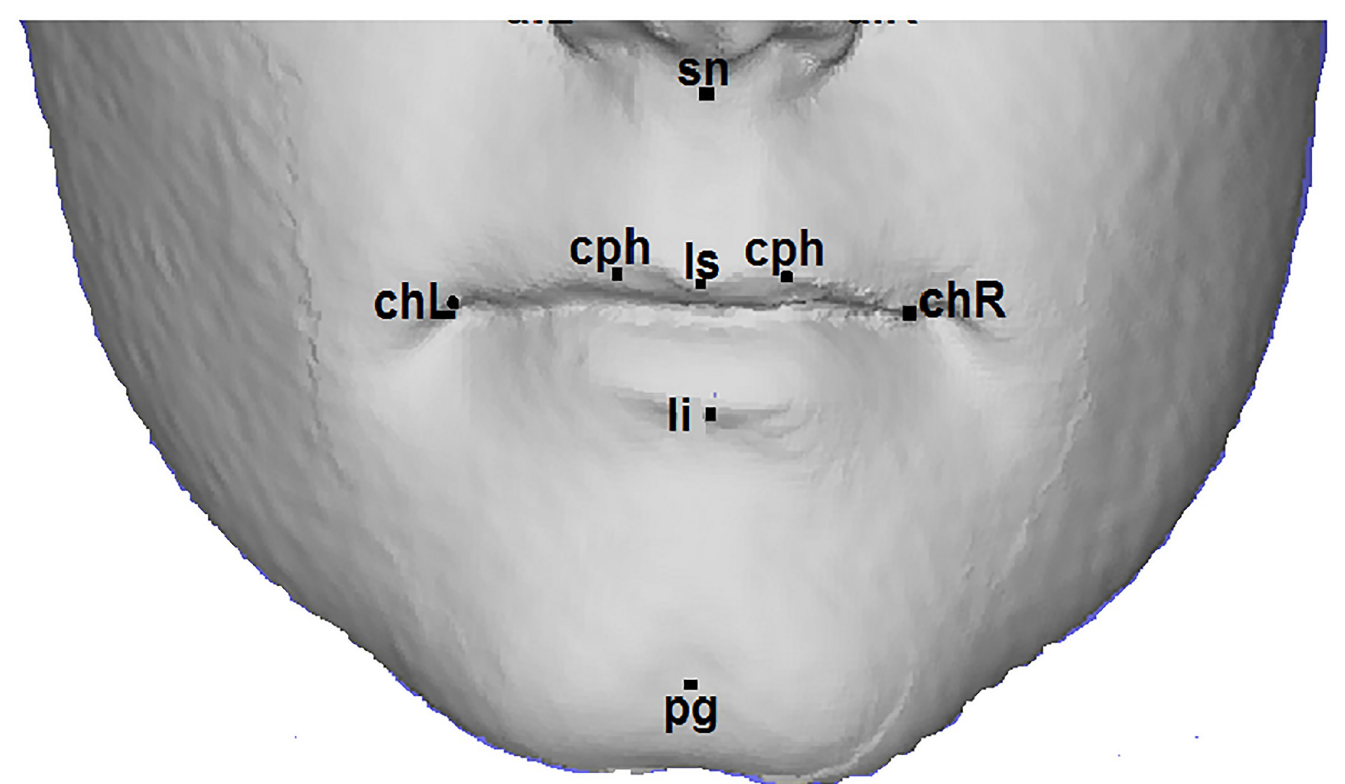
Fig 3. Lip landmarks. There are eight anthropometric landmarks localized in the lip region.